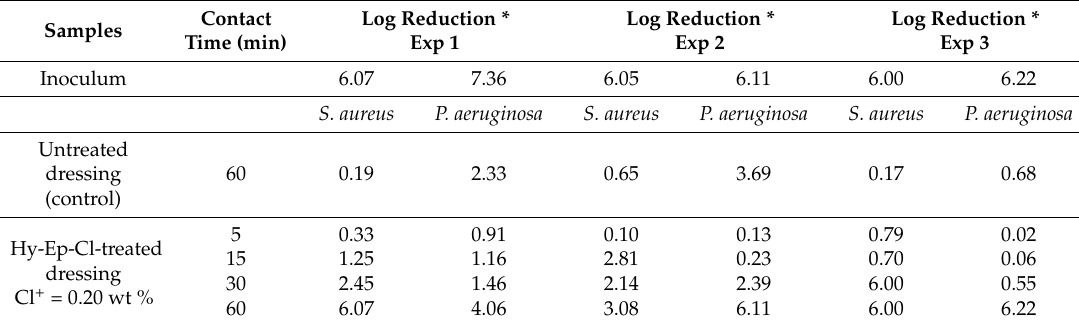
Table 4. Biocidal efficacy of Hy-Ep-Cl coated wound dressings.